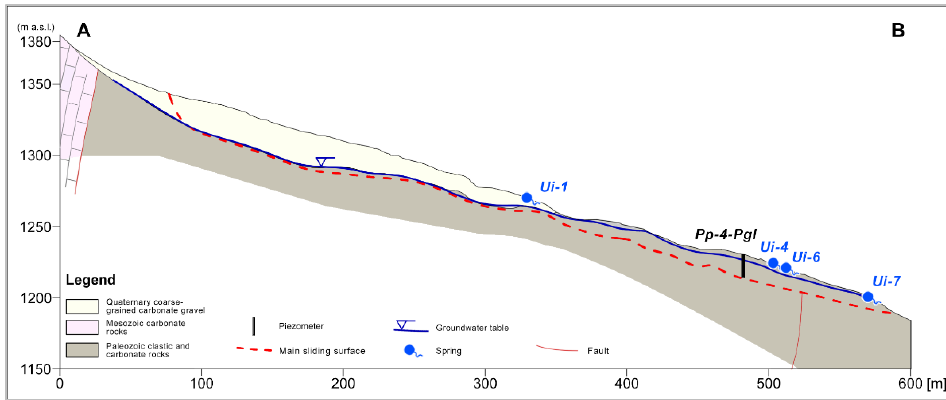
Figure 2. Cross-section (A – B cross-section is shown on Figure 1) of the Urbas